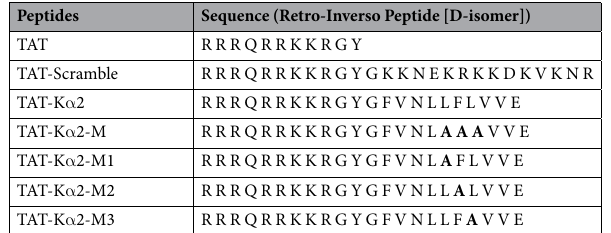
Table 1. Synthesized peptides in this study.